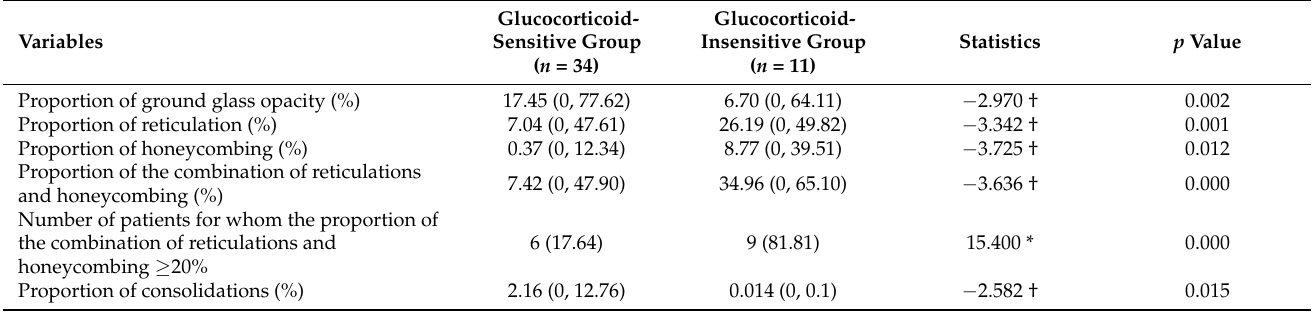
Table 3. Imaging features of the glucocorticoid-sensitive group and glucocorticoid-insensitive group.